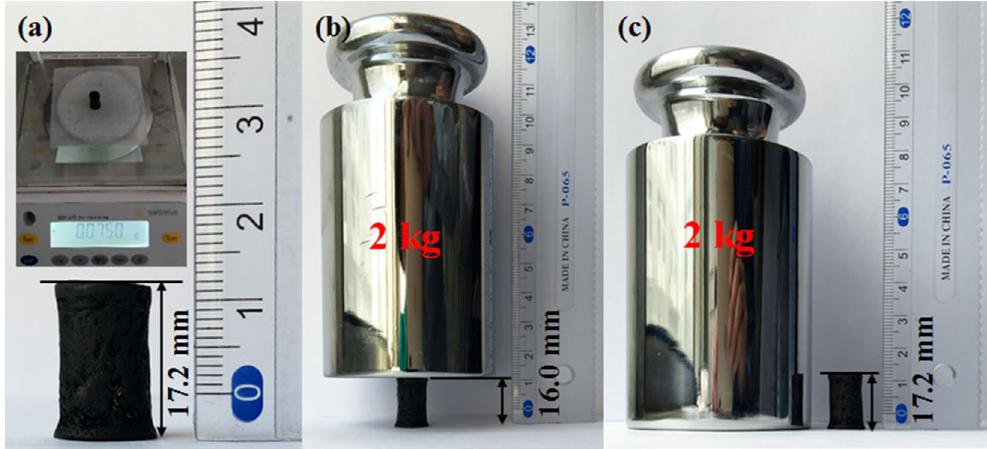
Figure 5. Photographs of a 75.0 mg graphene aerogel cylinder dried by supercritical ethanol supporting a 2 kg counterpoise without deformation. Digital photos of graphene aerogel in ( a ) original, ( b ) loaded, and ( c ) unloaded